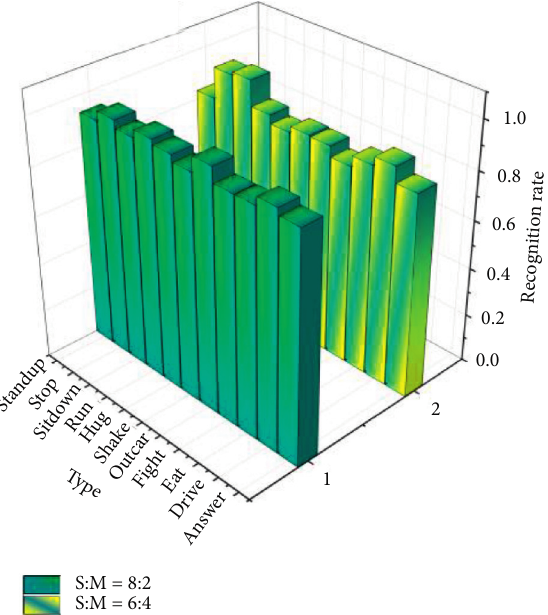
Figure 4: Hollywood for different classes of motion on S : M of 8: 2 and 6:4.